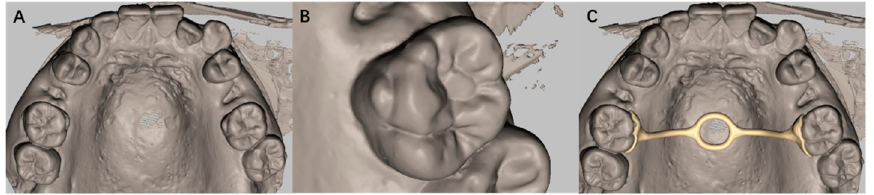
Figure 4. ( A ) Digital modal of dentition; ( B ) a big Carabelli cusp on the first upper molar; ( C ) a 3D TPA designed using the digital model.